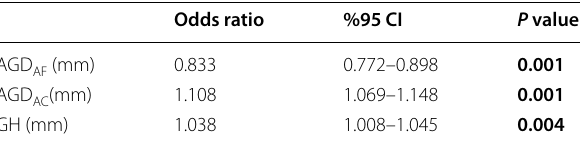
Table 3 Logistic regression analysis of anogenital distance parameters in terms of incontinence